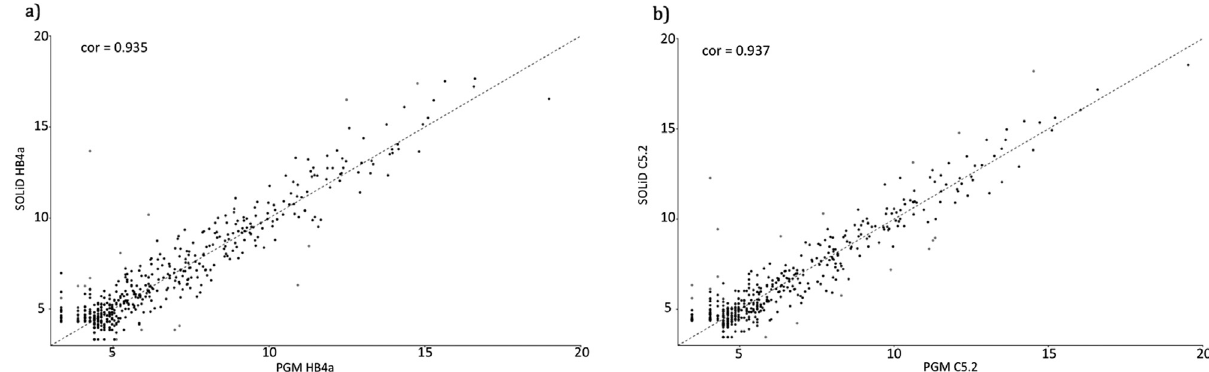
Figure 2 - Plots showing the miRNA expression-correlation analysis between SOLiD and PGM platforms for the cell lines HB4a (COR=0.935) (a) and C5.2 (COR=0.937) (b). Expression levels for each miRNA are given in normalized counts calculated by DESeq2 variance-stabilizing transformation. DifferentiallyrepresentedmiRNAscalculatedbyDESeq2areindicatedinred.ThePearsoncorrelationcoefficient(cor)wascalculatedforeachcellline.